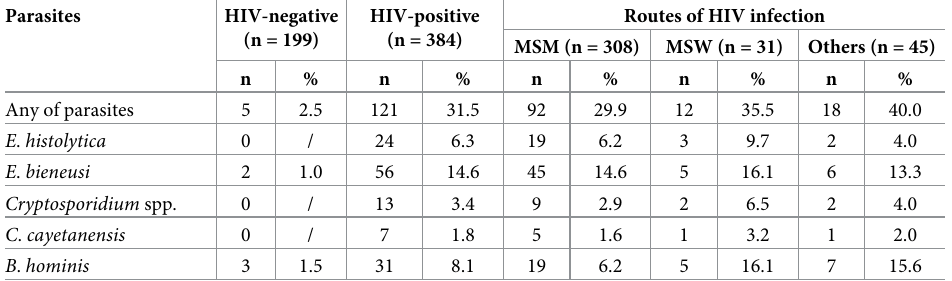
Table 1. Prevalence of five enteric intracellular parasites among HIV-negative and HIV-positive participants with different transmission routes.